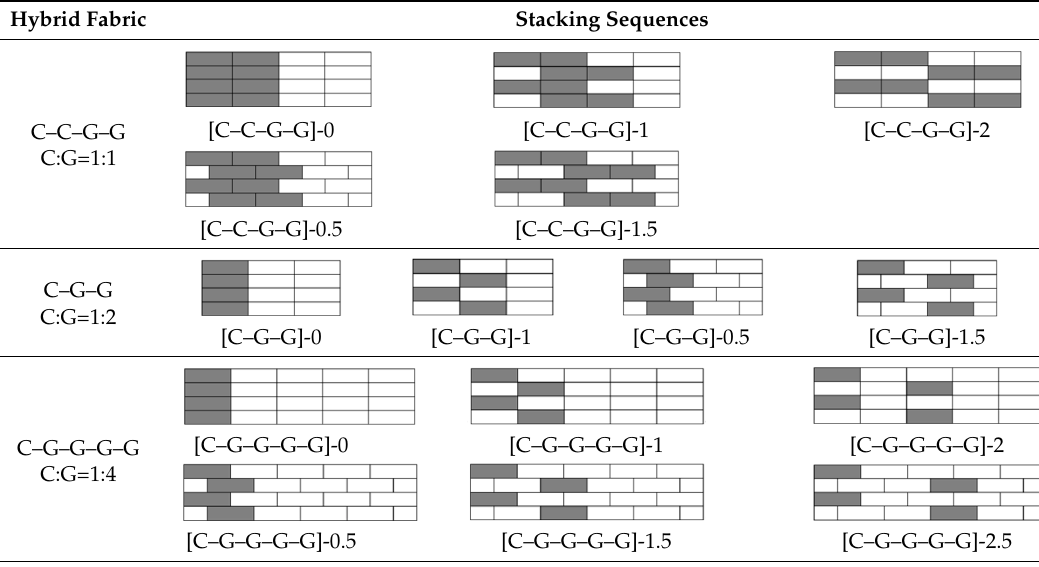
Table 4. Stacking configurations of intralayer hybrid structures.